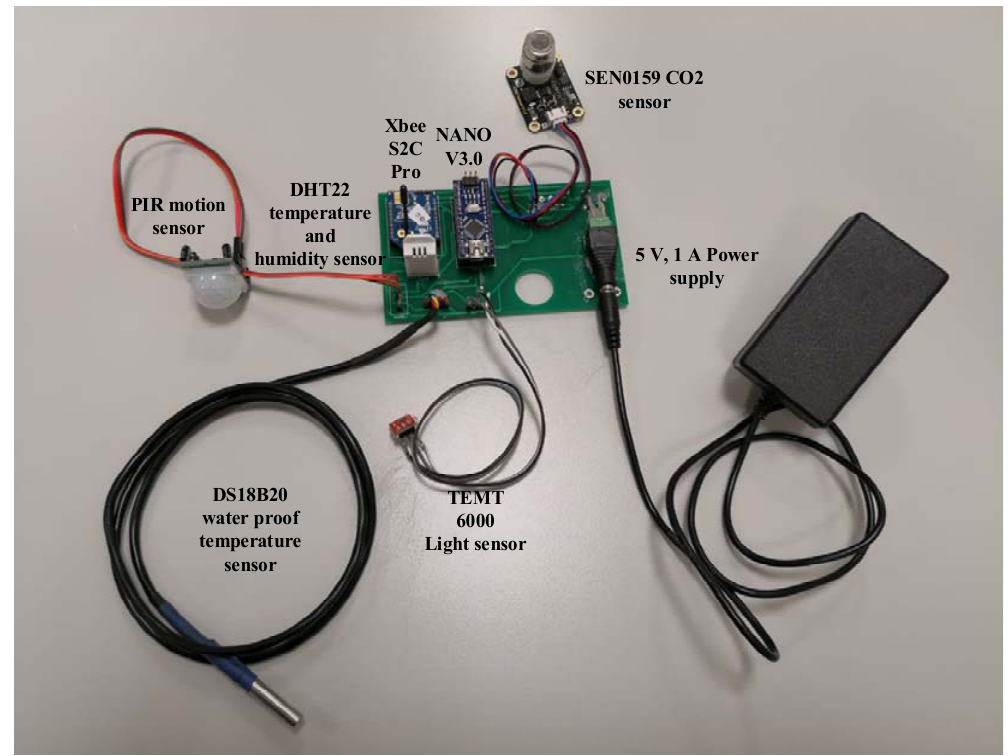
Figure 7. Room condition monitoring circuit.